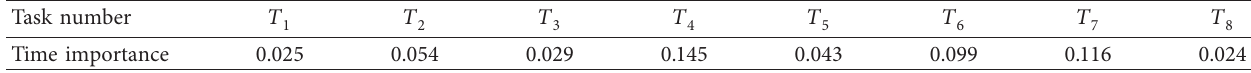
Table 1: Time importance of each task.